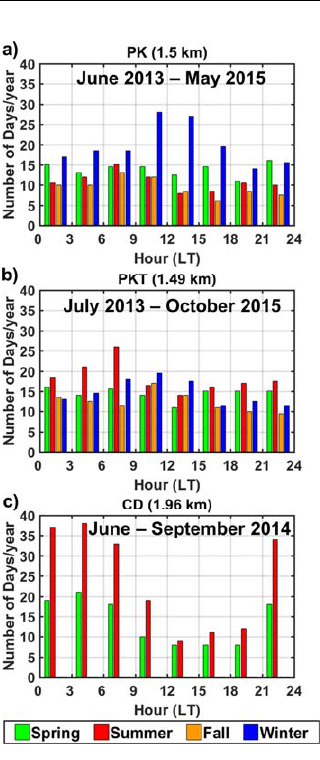
Figure 3. Diurnal cycles of fog occurrences in each season (spring: April-May-June, summer: July-August-September, fall: October–November–December, and winter: January–February–March) sampled by fog collectors at PK ( a ), PKT ( b ), and CD ( c ). Note the elevation of each site is denoted in parentheses after its name and the corresponding observation period is indicated at the top of each plot.